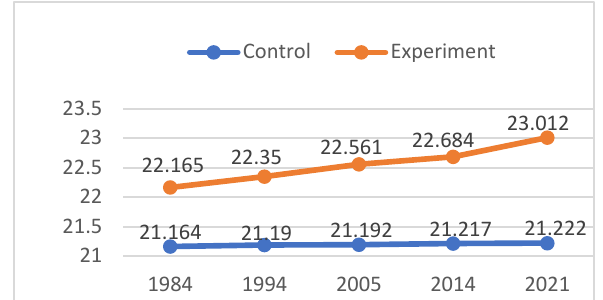
Figure 10. The average temperature changes of the control area and the test area in degrees Celsius during the years 1984 to 2021.